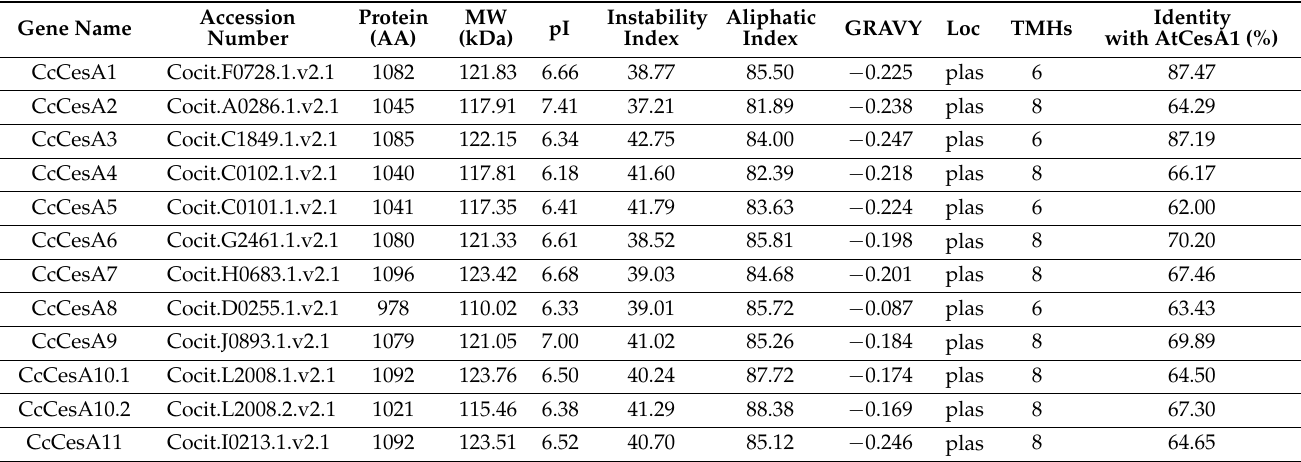
Table 2. Characteristics of CesA gene family in C. citriodora